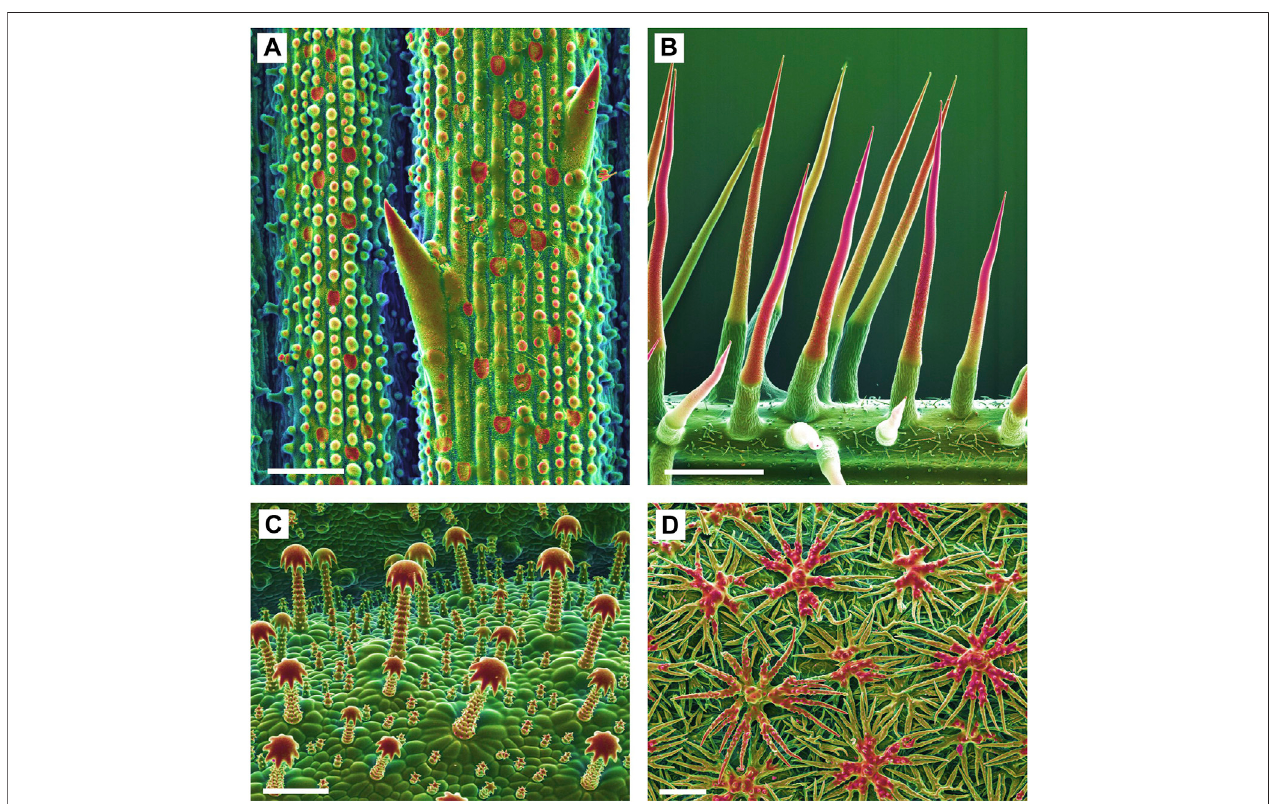
FIGURE1| Biomineralized plant surface structures. Combined topographic(SE) and compositional (BSE) contrastSEM images showing mineralized structures in red color. (A) : Sharp tips and abrasive epidermis inclusions in a grass ( Spartina pectinata ). (B) : Stinging hairs of stinging nettles ( Urtica mairei ). (C) : Complex glochidiate trichomes of Blumenbachia insignis . (D) : A dense cover of the leaf surface with stiff peltate, branched trichomes on Brassicaceae ( Phyllolepidum cyclocarpum ). Scale bars: A (cid:1) 50 μ m; B (cid:1) 1 mm; C, D (cid:1) 100 µm.